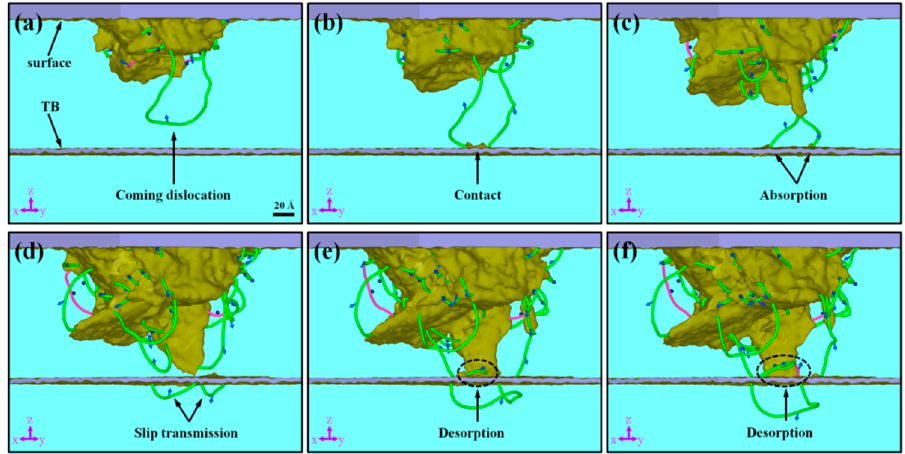
Figure 2. Evolution of dislocations in sample: ( a ) h = 23 Å, ( b ) h = 27.05 Å, ( c ) h = 34.1 Å, ( d ) h = 43.4 Å, ( e ) h = 45.95 Å, and ( f ) h = 47.45 Å. <111> type dislocations are indicated with green lines, <100> type dislocations with pink lines, and Burger’s vectors with blue arrows.